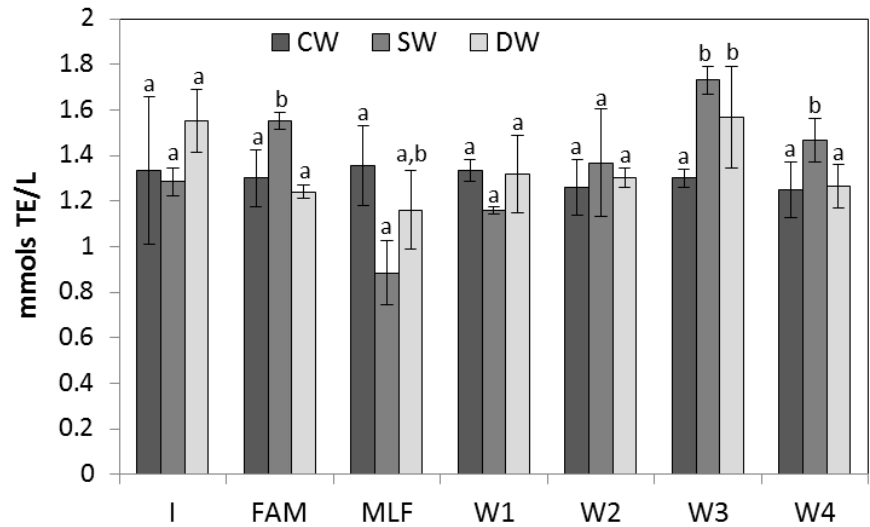
Figure 1. Values of antioxidant activity measured with the ABTS method during the winemaking process in CW, SW, and DW. Different letters in the same stages of winemaking indicate significant differences between CW, SW, and DW by ANOVA test ( p < 0.05).